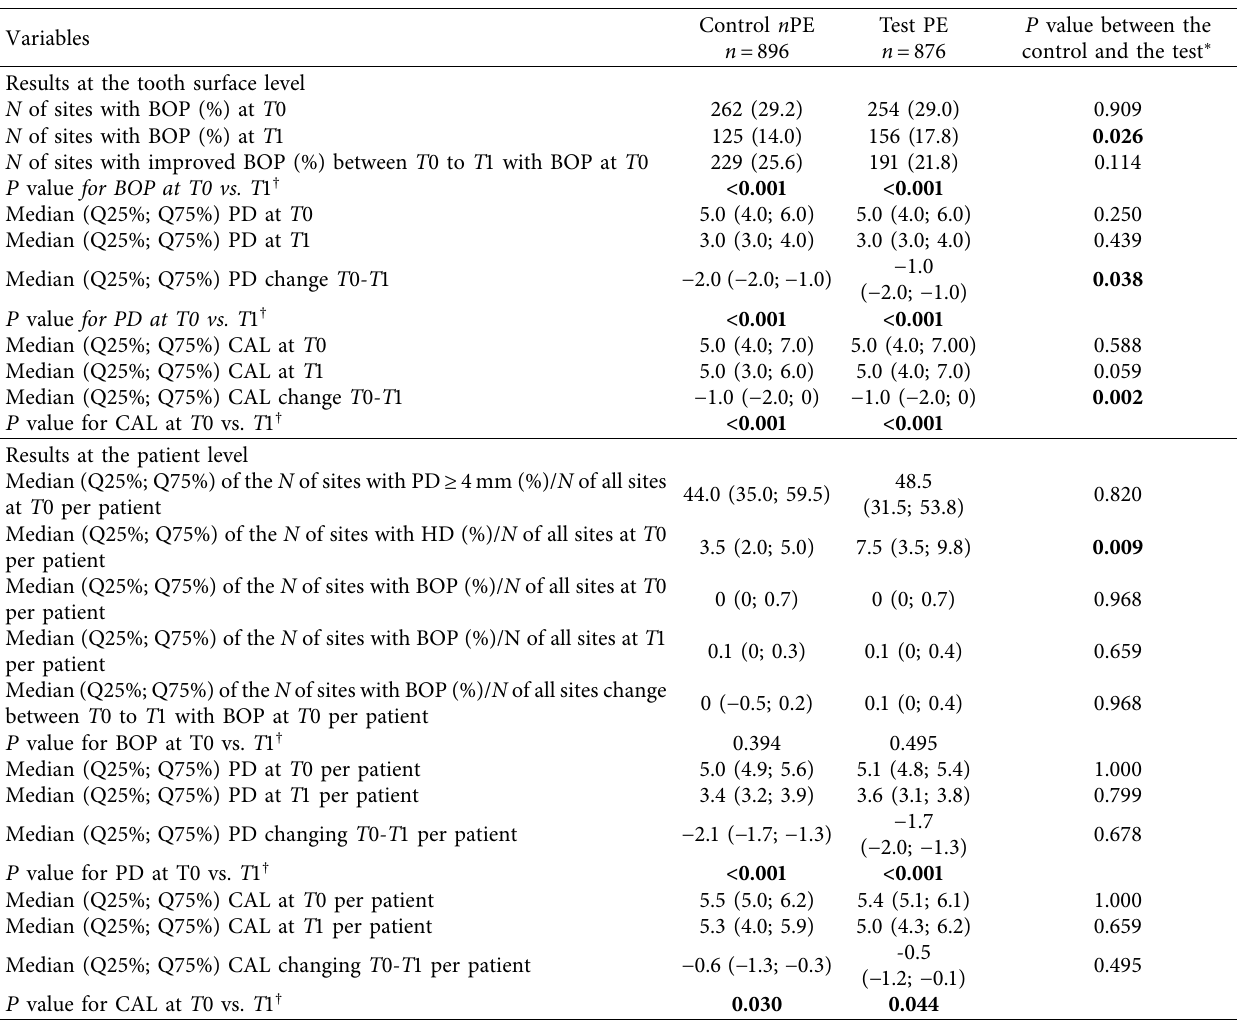
Table 2: Treatment results, part I (only sites with PD ≥ 4 mm at T